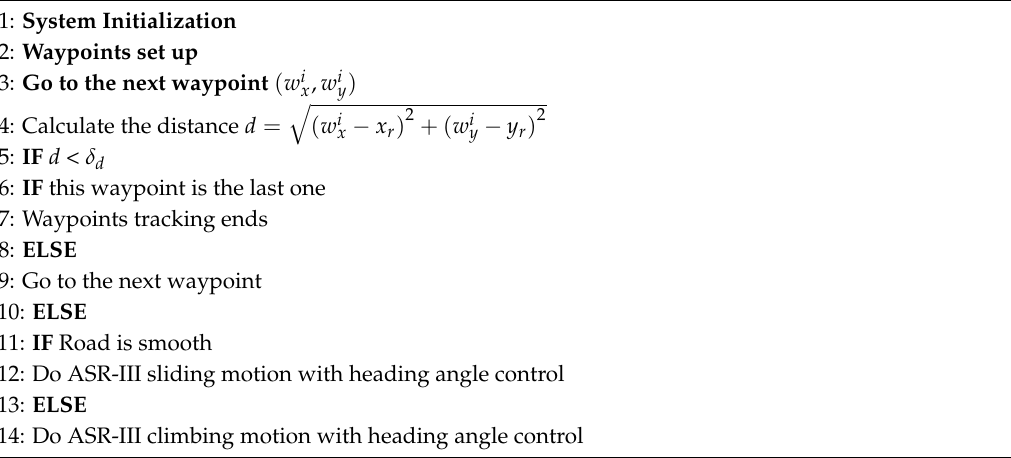
Algorithm A1 Waypoints tracking algorithm with Closed-loop PID Control